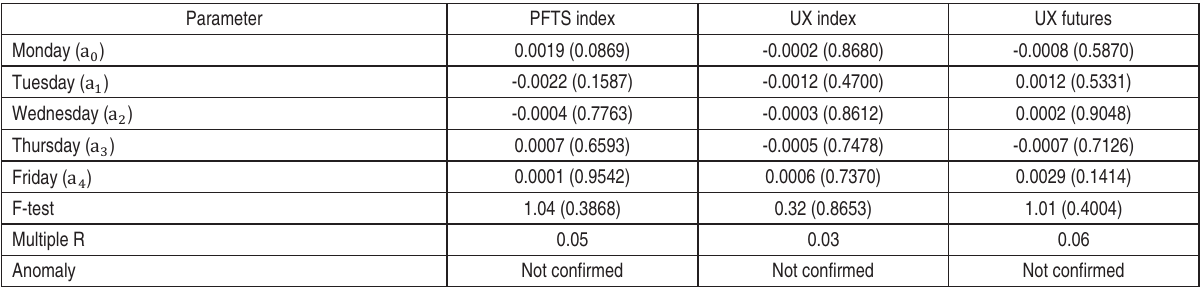
Table B10. Regression analysis with dummy variables of the day-of-the-week effect for PFTS index, UX index